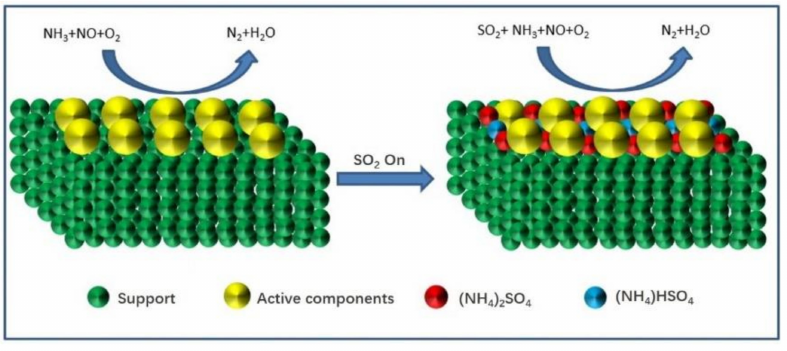
Figure 1. The formation process of (NH 4 ) 2 SO 4 and NH 4 HSO 4.